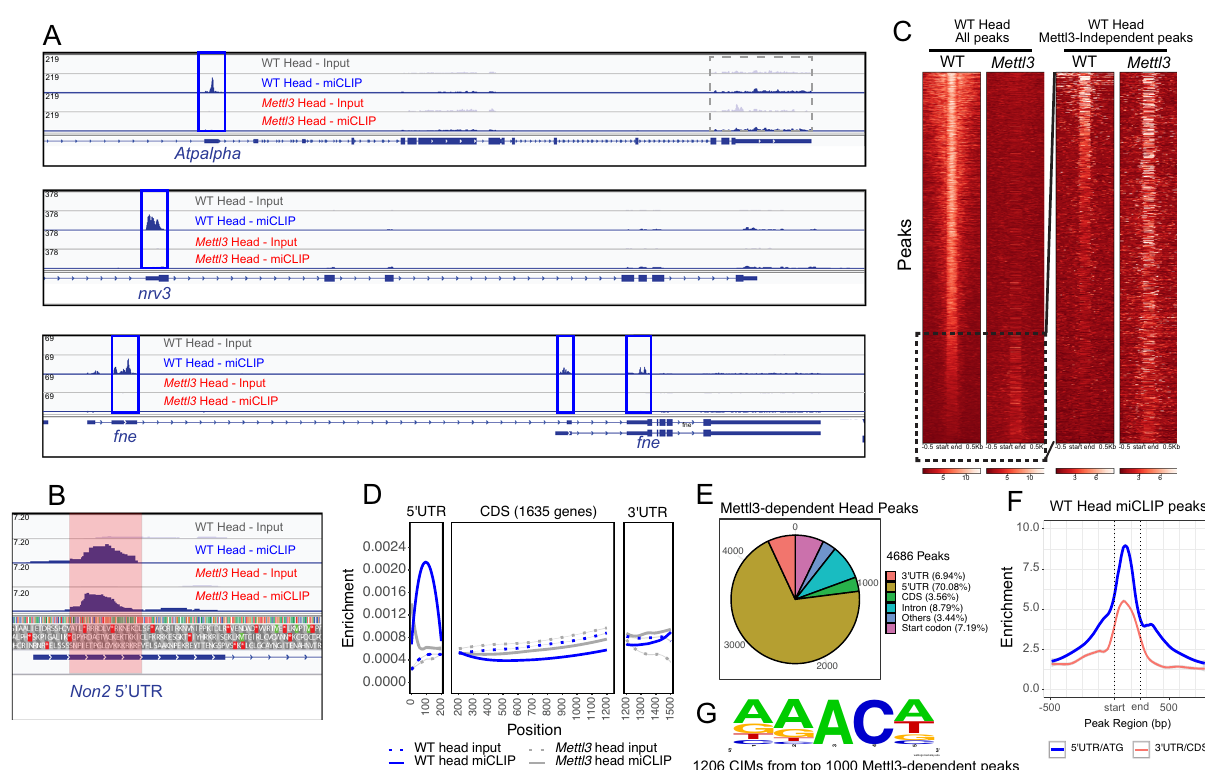
Fig. 4 High stringency mapping of the Drosophila m 6 A methylome reveals new features. A IGV screenshots of genes that exemplify archetypal 5 ′ UTR miCLIP enrichment and the utility of wild type vs. Mettl3 mutant comparisons. The IGV tracks above the transcript model depict miCLIP and input libraries from wild type and Mettl3 female heads. Note the 5 ′ UTRs of all three genes ( Atpalpha, nrv3 , and fne ) contain prominent Mettl3-dependent peaks (blue box). Other exonic regions sequenced in miCLIP libraries are not enriched above input libaries (e.g. gray box). B IGV screenshot of Non2 illustrates a 5 ′ UTR Mettl3-independent peak (red box). C Heatmaps of Mettl3-dependent and -independent m 6 A peaks. Heatmaps of input normalized miCLIP signals at Mettl3-dependent and independent peaks. Each line represents miCLIP enrichment over input across a MACS2-called peak, as well as 500 nt fl anking regions. Heatmaps on the left are all peaks including Mettl3-dependent and independent m 6 A peaks. Mettl3-independent m 6 A peaks are displayed in the right panels. Note that the scales are different for the heatmap panels. Approximate locations of Mettl3-independent m 6 A peaks within all peaks are indicated by a dashed box. D Metagene pro fi les of miCLIP and input signals along a normalized transcript using genes that contain high-con fi dence m 6 A peaks in head libraries. An overwhelming 5 ′ UTR enrichment is observed. E Metagenes of enrichment at high-con fi dence m6A peaks that have been group as 5 ′ UTR/start codon and 3 ′ UTR/CDS regions. Metagenes are produced by averaging signals from input normalized miCLIP from WT head. On average, stronger signals are observed at 5 ′ UTRs/start codons. Peak start and end are speci fi ed on the x -axis. Dashed lines include the start and end locations of peaks. F Pie chart depicting the fraction of m 6 A peaks in different transcript segments. G Nucleotide content surrounding CIMs located within the top 1000 Mettl3-dependent m 6 A peaks in head. Source data are provided as a Source Data fi le and Supplementary Dataset